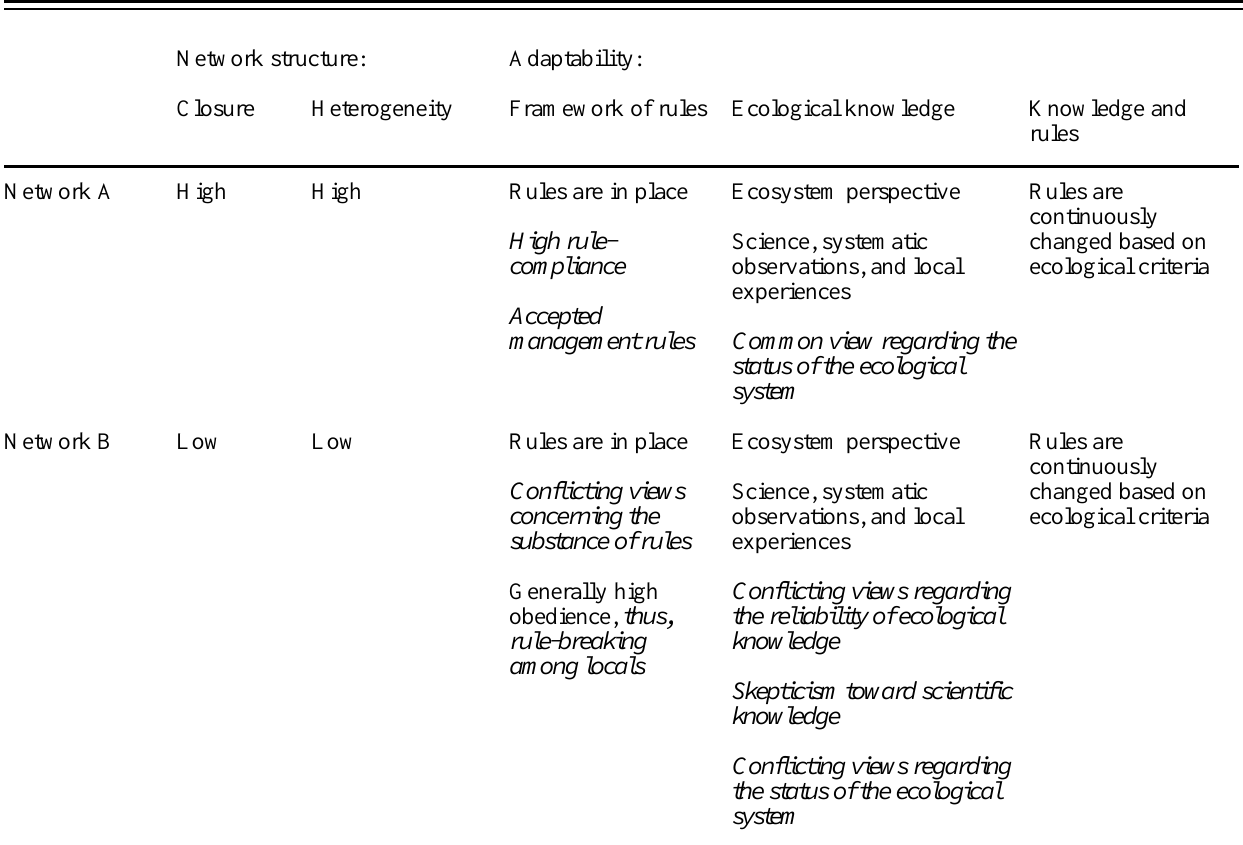
Table 3. Network structure and